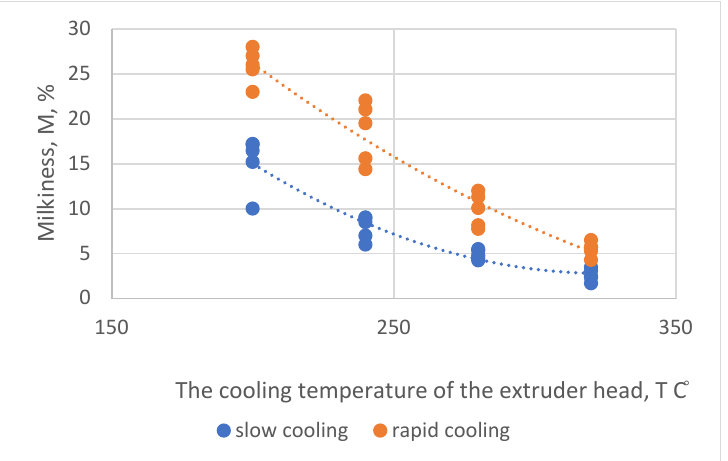
Figure 13. Dependence of milkiness (M) on the average cooling temperature of the extruder head.